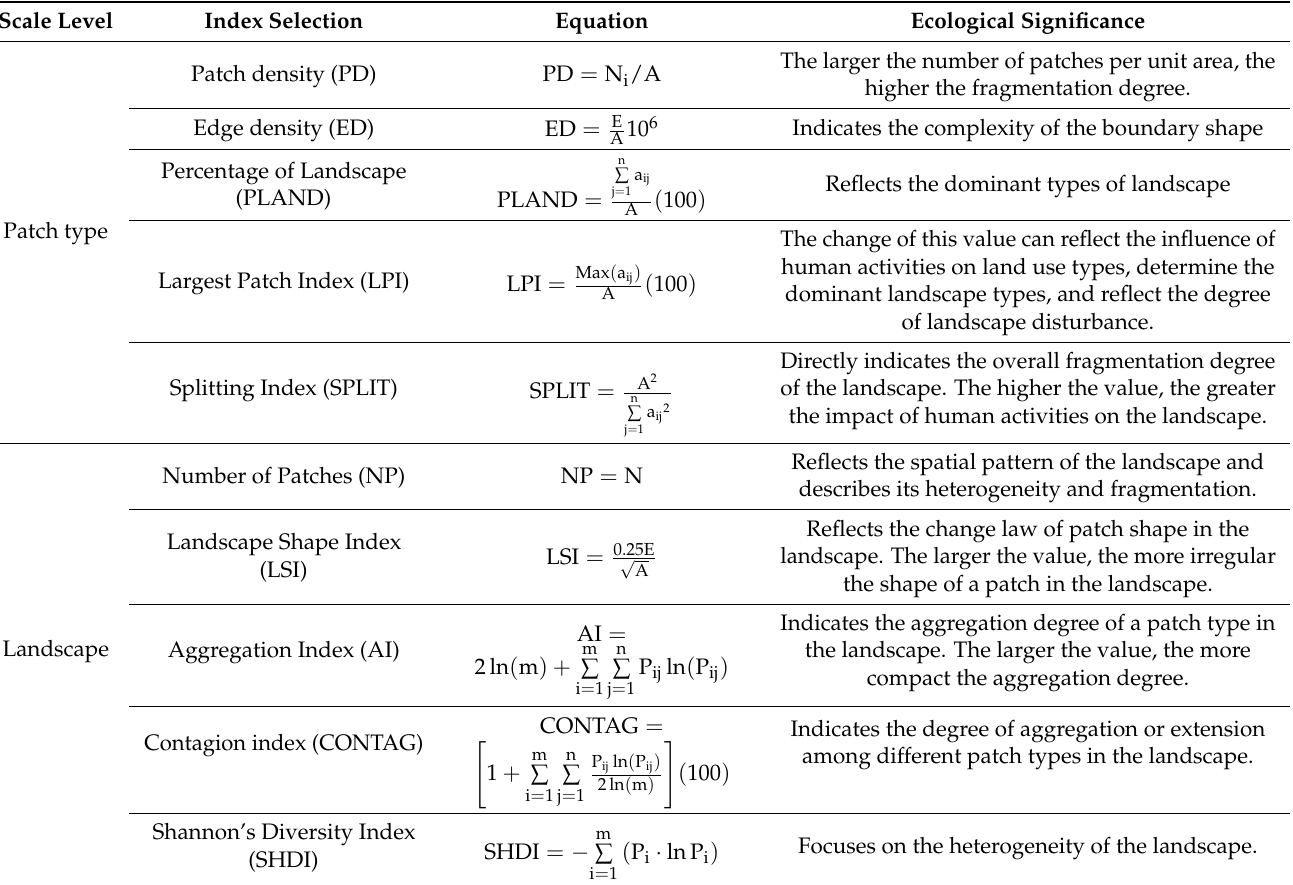
Table 4. Landscape Pattern Index of Yellow River Basin (Henan